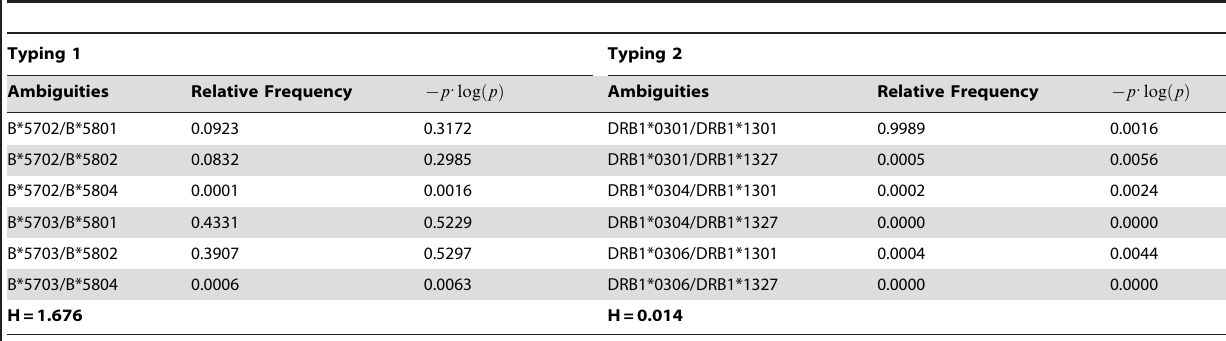
Table 3. An illustration of two ambiguous typing results with the same number of possible allele sub-types and different level of ambiguity as measured by